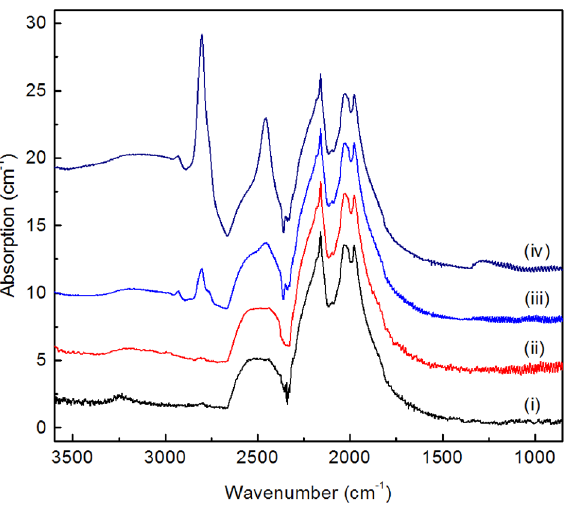
Figure 4. Representative infrared absorption spectra of diamonds produced in REM-C systems. The spectra were recorded for diamond crystals synthesized in (i) La–C, (ii) Ce–C, (iii) Tb–C and (iv) Lu–C systems at 2000 °C. The spectra were displaced vertically for